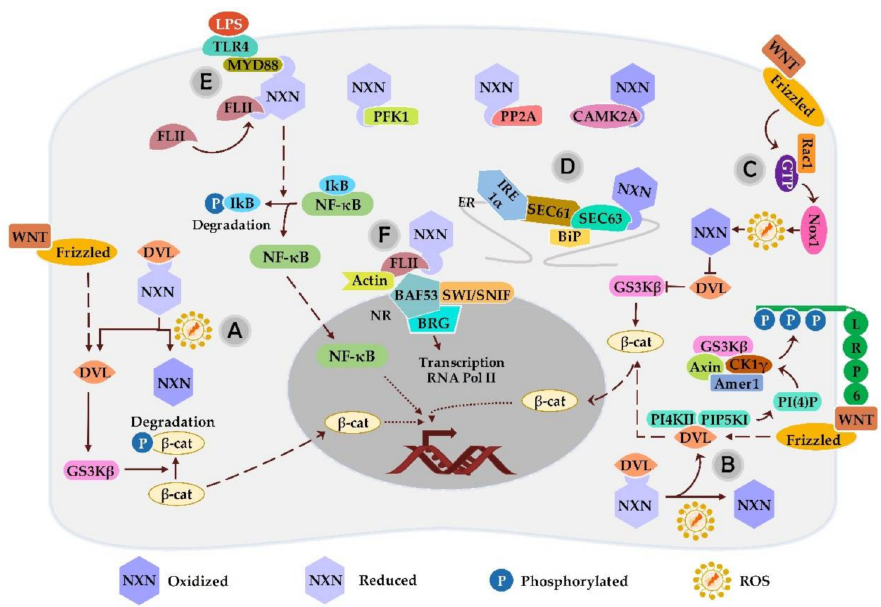
Figure 3. Schematic representation of NXN-regulated signaling pathways. ( A ) NXN negatively regulates WNT signaling by binding to DVL, but its oxidation activates GSK3 β and the down- stream signaling through β -catenin stabilization and nuclear translocation. ( B ) NXN/DVL binding oxidation induces the recruitment of DVL, phosphatidylinositol 4-kinase type-II α (PI4KII), and phosphatidylinositol-4-phosphate 5-kinase (PIP5KI) to Frizzled/WNT complex, stimulates phos- phatidylinositol 4-phosphate [PI(4)P] production, and after producing phosphatidylinositol 4,5- bisphosphate [PI(4,5)P2], Amer1/Axin/GSK3 β /CK1 γ clustering and the subsequent phosphoryla- tion of LRP6 is promoted. ( C ) Rac1 activation by WNT/ β -catenin pathway induces generation of NOX1-derived ROS, which oxidizes and dissociates NXN from DVL. The last, suppresses GSK3 β activity resulting in β -catenin stabilization and translocation into the nucleus. ( D ) NXN could be oxidizing and stabilizing the SEC63-dependent complex and contribute to co-translational protein translocation into endoplasmic reticulum (ER). ( E ) After lipopolysaccharide (LPS) stimulus, MYD88 is recruited to TLR4, which leads to I κ B degradation and then, NF- κ B moves into the nucleus to activate gene transcription. Upon activation of TLR4, H 2 O 2 is produced leading to the oxidation of some NXN molecules; however, NXN also forms complex with FLII and MYD88 (FLII/NXN/MYD88) to avoid the unnecessary hyperactivation of TLR4/MYD88 signaling. ( F ) By interacting with FLII, it is likely that NXN forms a complex with nuclear receptors (NR) and participates in chromatin the remodeling process, as well as, contributes to the transcription initiation of NR-targeted genes. NXN interaction with PFK1 and PP2A could be associated with TIGAR and Akt signaling pathways, respectively; and NXN/CAMK2A interaction has not been linked yet with the participation of a specific signaling pathway, as described